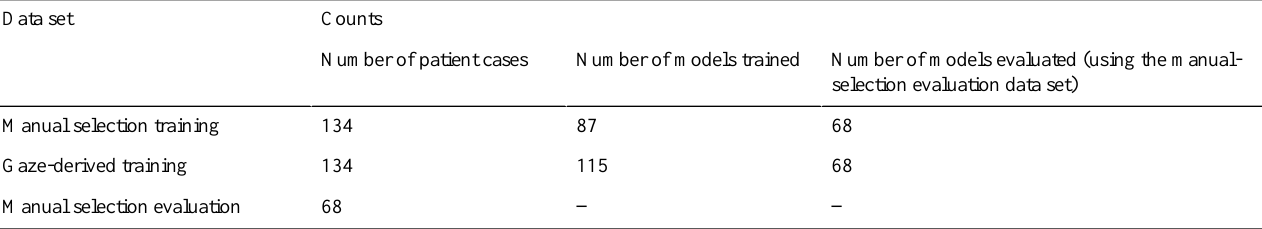
Table 2. Summary of data sets, models trained, and models evaluated. Each model predicts if a single electronic medical record data item is relevant.